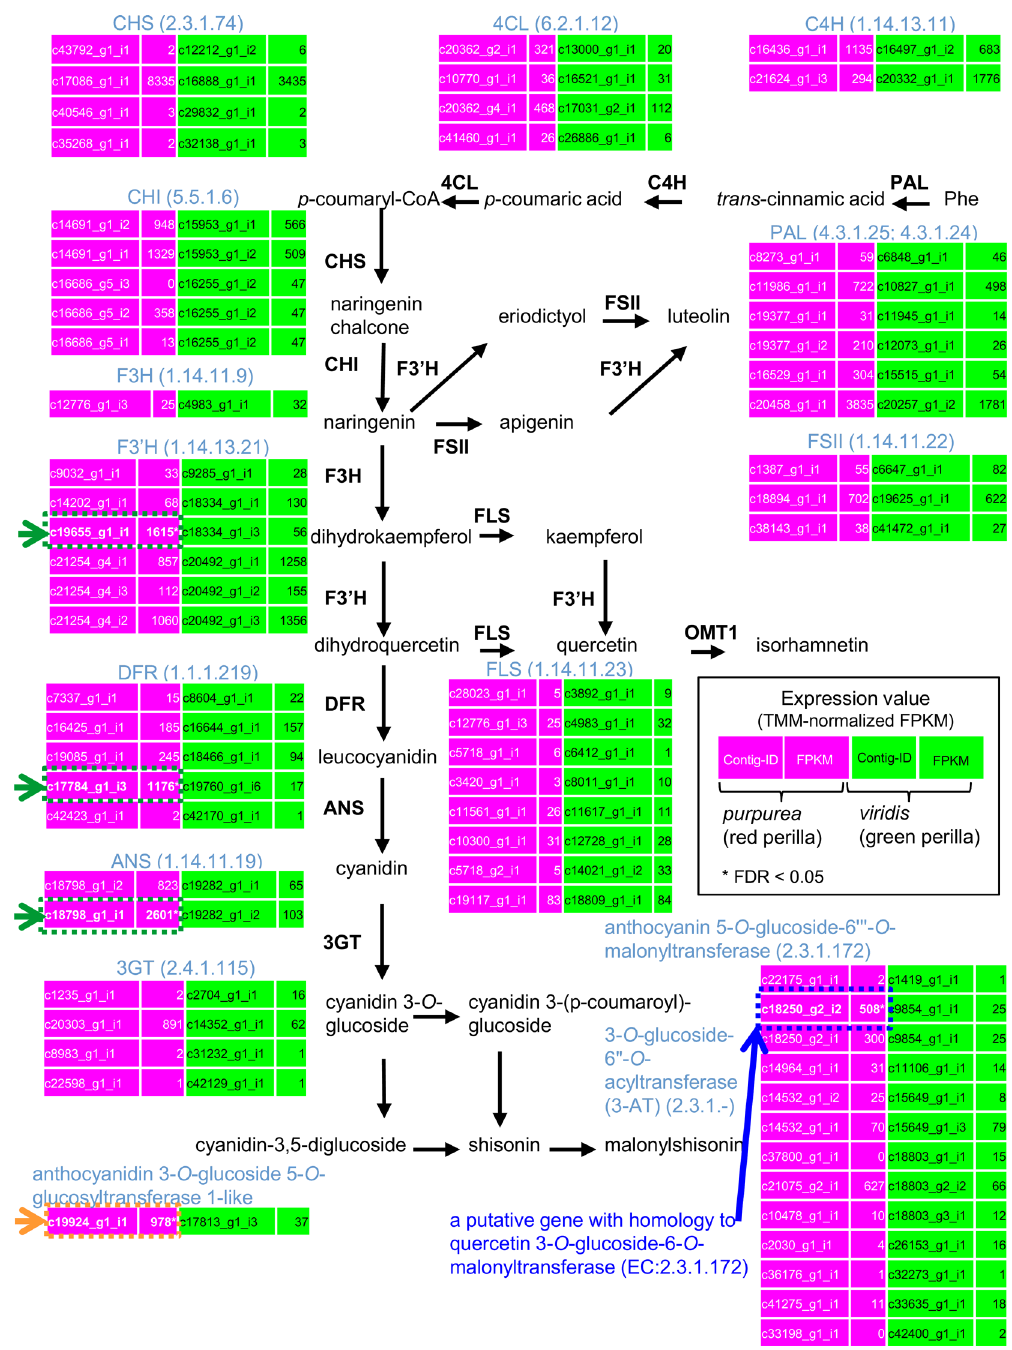
Fig 5. Comparative representation of transcriptome data in red and green forms of perilla plants. Biosynthetic pathways and the expression of unigenes involved in the biosynthesis of phenylpropanoid and flavonoid skeletons are shown. The expression levels (TMM-normalized FPKM values) of unigenes encoding the enzymes of each step are displayed. Homologous genes in red and green perilla represent the reciprocal best-hit BLAST results. Asterisks identify the false discovery rate, (FDR) < 0.05, with the TCC package [43]. TMM, Trimmed Mean of M values [63]; PAL, phenylalanine